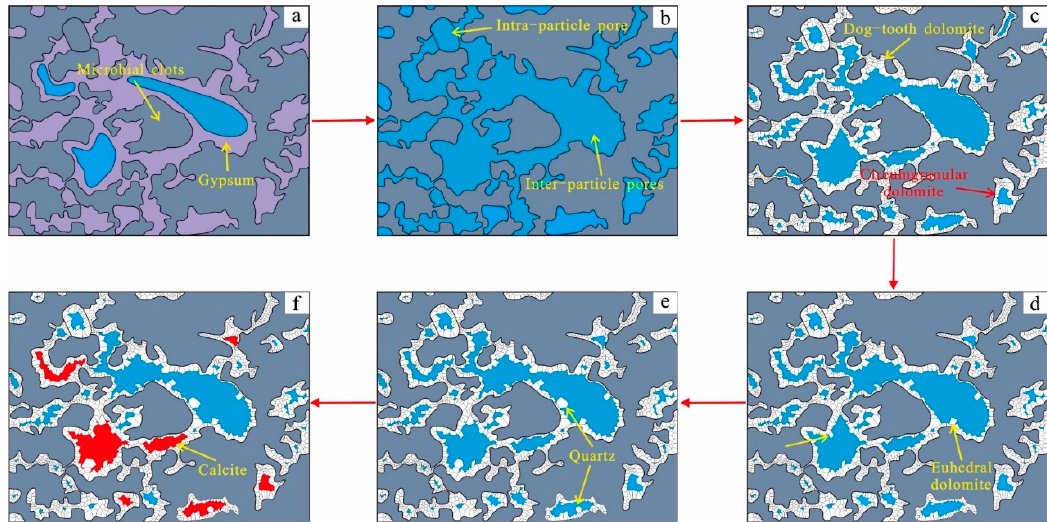
Figure 13. Evolution of microbial inter-particle pores in the Leikoupo Formation. ( a ) In the sedimentary period, initial inter-particle pores formed, and gypsum precipitated from seawater; ( b ) In the syn-depositional period, gypsum and a few clots dissolved, and inter-particle pores and intra-particle pores formed; ( c ) In shallow burial period, circumgranular and dog-tooth cements formed in the pores; ( d ) As the depth increased, euherdral dolomite precipitated; ( e ) Quartz crystal precipitated in the deep burial period; ( f ) Clear coarse calcite spar precipitated in the deep burial period.